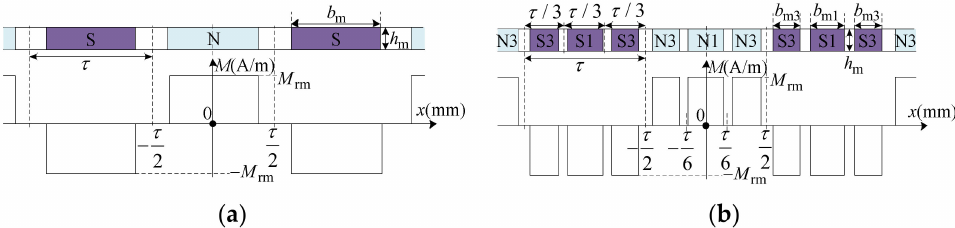
Figure 1. Secondary structures of PMLSMs: ( a ) conventional non-salient pole secondary; ( b ) PM width-modulation array with a carrier ratio s =